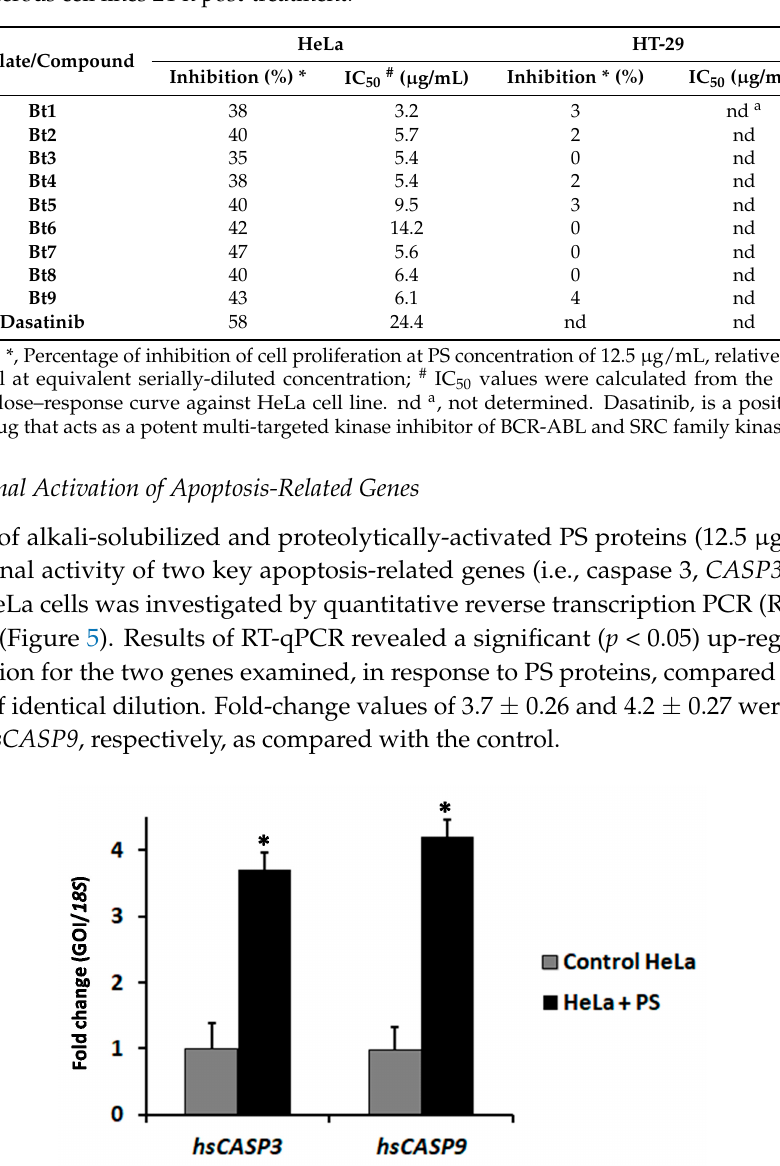
Table 2. Cytotoxic activity of different alkali-solubilized and trypsinized parasporal crystal proteins against cancerous cell lines 24-h post-treatment.